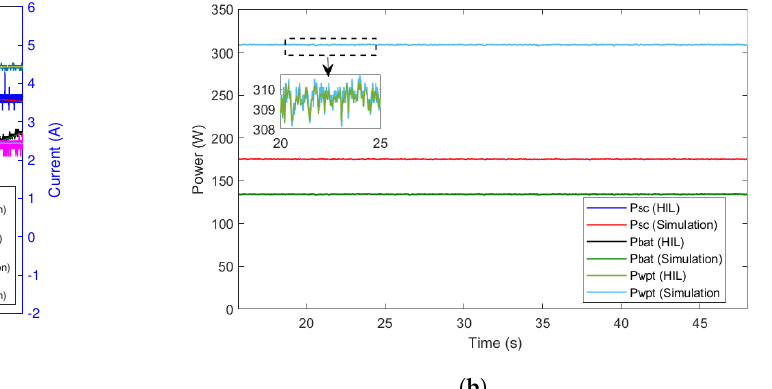
Figure 21. For V sci = 35 V ( a ) V sc , I sc , V bat and I bat ( b ) P sc , P wpt , P bat